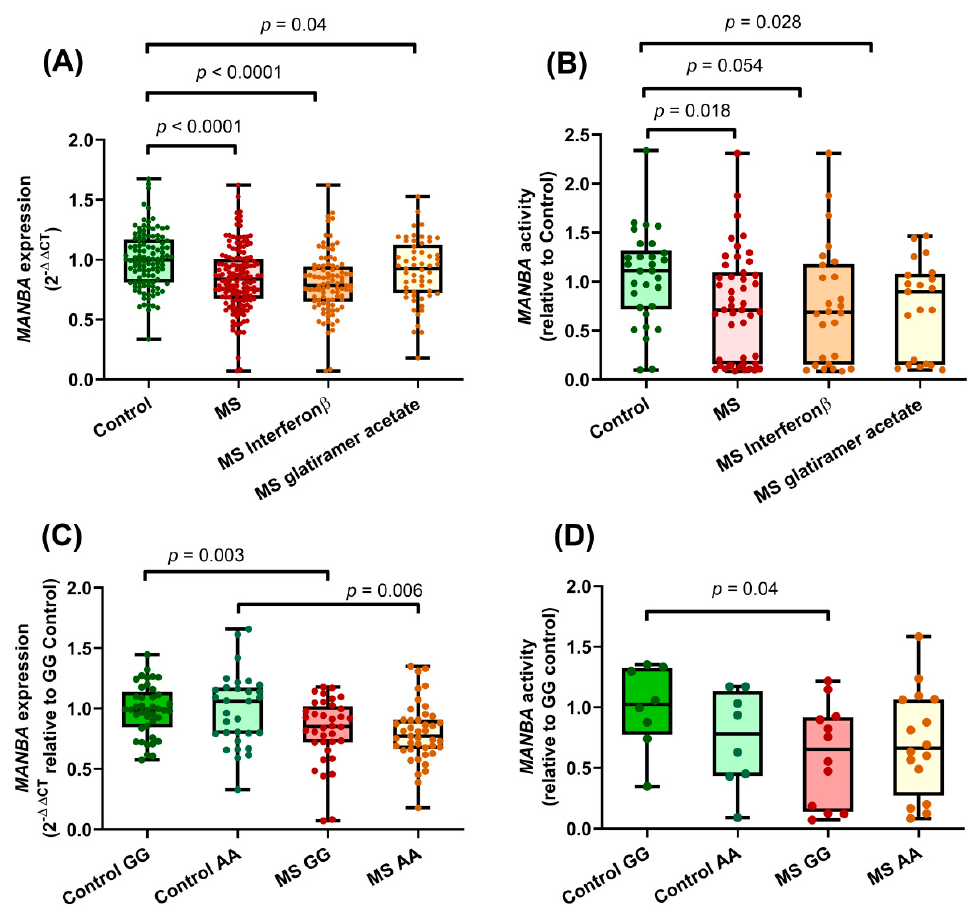
Figure 1. MANBA expression and activity in PBMCs. ( A ) MANBA expression in PBMCs from healthy donors and MS patients (controls n = 112; MS n = 151; interferon β n = 94; glatiramer acetate n = 57). Percentage of difference between means in Control vs. MS = 15.5 ± 3.13%; Control vs. interferon β = 19.31 ± 3.43%; Control vs. MS glatiramer acetate = 9.4 ± 4.0%. ( B ) MANBA activity in PBMCs from healthy donors and MS patients (controls n = 30; MS n = 47; interferon β n = 26; glatiramer acetate n = 21). Percentage of difference between means in Control vs. MS = 29.59 ± 12.2%; Control vs. MS interferon β = 28.61 ± 14.52%; Control vs. MS glatiramer acetate = 30.8 ± 13.64%. ( C ) MANBA expression in controls and MS patients stratified by rs7665090 genotypes (controls GG n = 41; controls AA n = 31; MS GG n = 36; MS AA n = 43). Percentage of difference between means in Control GG vs. MS GG= 16.84 ± 5.5%; Control AA vs. MS AA= 18.82 ± 6.36%. ( D ) Effect of rs7665090 genotypes on MANBA activity (controls GG n = 10; controls AA n = 9; MS GG n = 13; MS AA n = 14). Percentage of difference between means in Control GG vs. MS GG = 39.17 ± 17.7%. Box and whiskers diagrams: the line represents the median value, the box the 25 and 75 percentiles and whiskers mark maximum and minimum values. All comparisons were performed with Student’s t